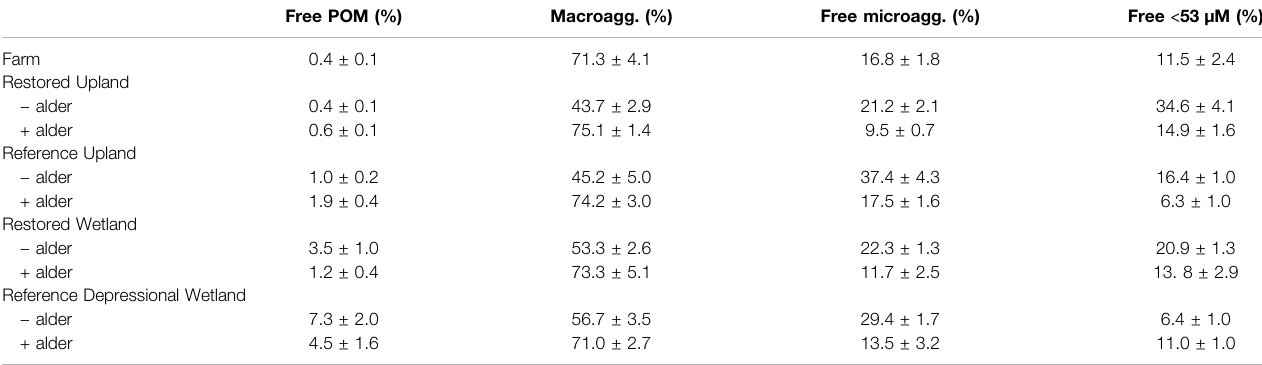
TABLE 3 | Distribution of bulk soil mass in four free fractions of hierarchical aggregates from nine sites investigated in this study.